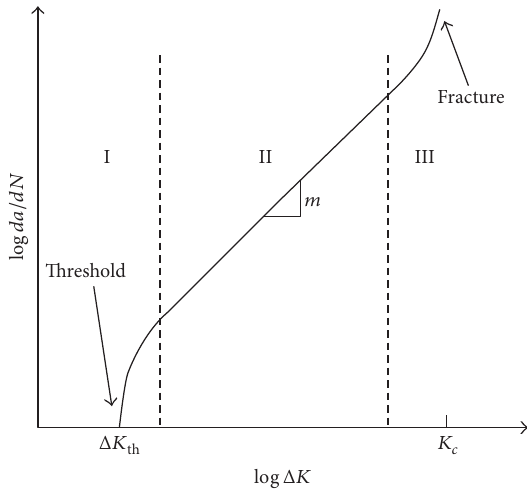
Figure 1: Typical sigmoidal curve of fatigue crack growth [21].